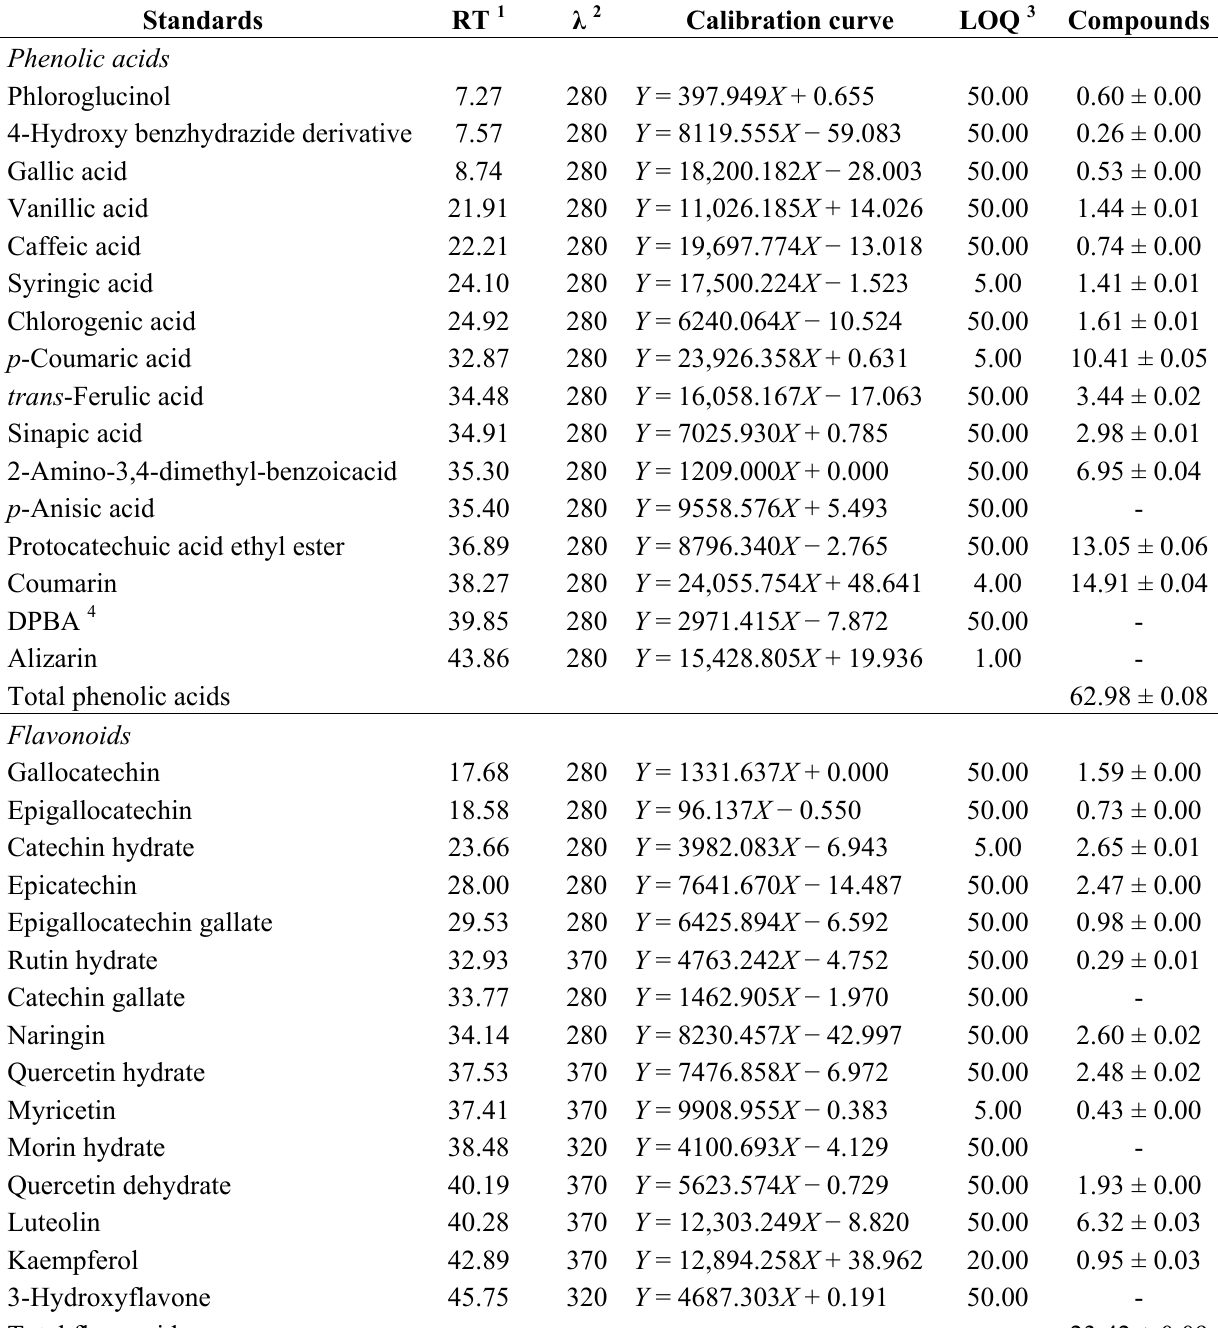
Table 3. Concentrations of phenolic acids and flavonoids of SBS extracts.